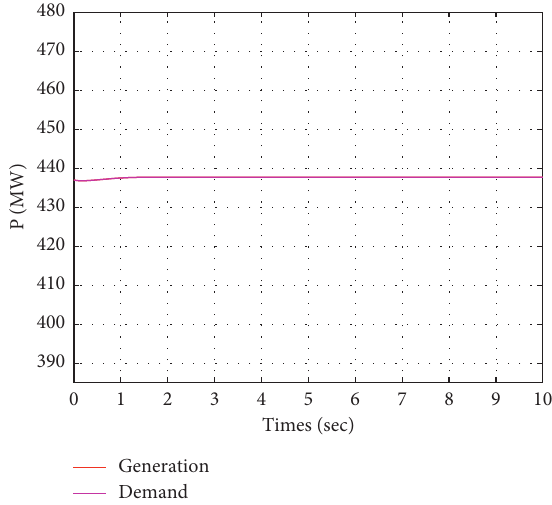
Figure 6: The incremental cost of generator λ eration constraints.